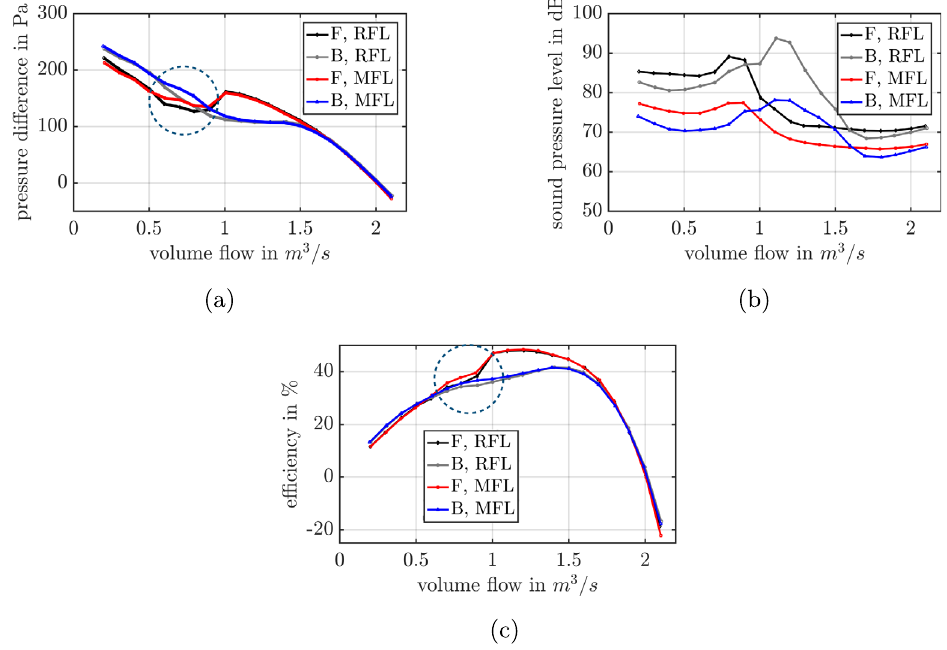
Figure 15. Characteristic curves of long MPA (MFL setup). (a) Pressure rise. (b) Sound pressure level. (c) Ef fi